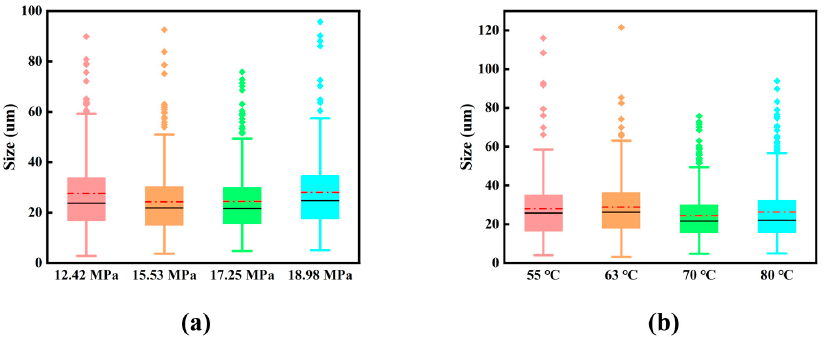
Figure 10. Pore size distribution of polyurea tensile fracture holes: ( a ) different spraying pressures under the 70 °C; and ( b ) different spraying temperatures under the 17.25 MPa.